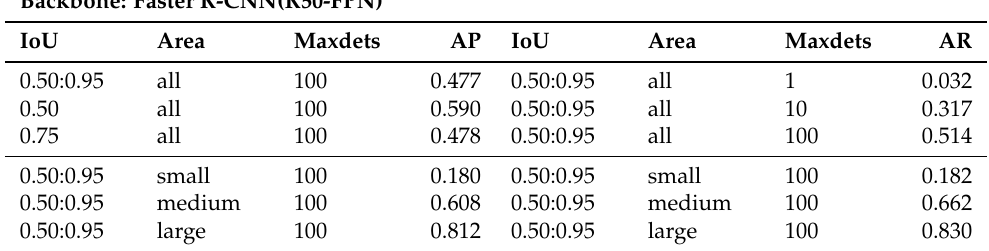
Table 3. COCO evaluation metrics for object detection using Faster R-CNN (R50-FPN) baseline. The metric maxdets specifies the maximum number of detections per image for calculating the average precision (AP) and average recall (AR).